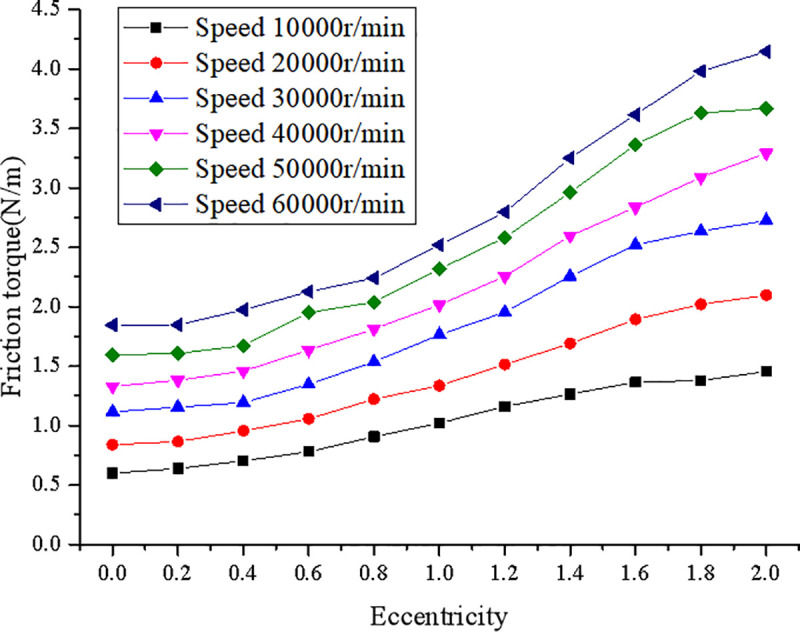
The influence of eccentricity on the friction torque of the hybrid bearing system at different rotating speeds.